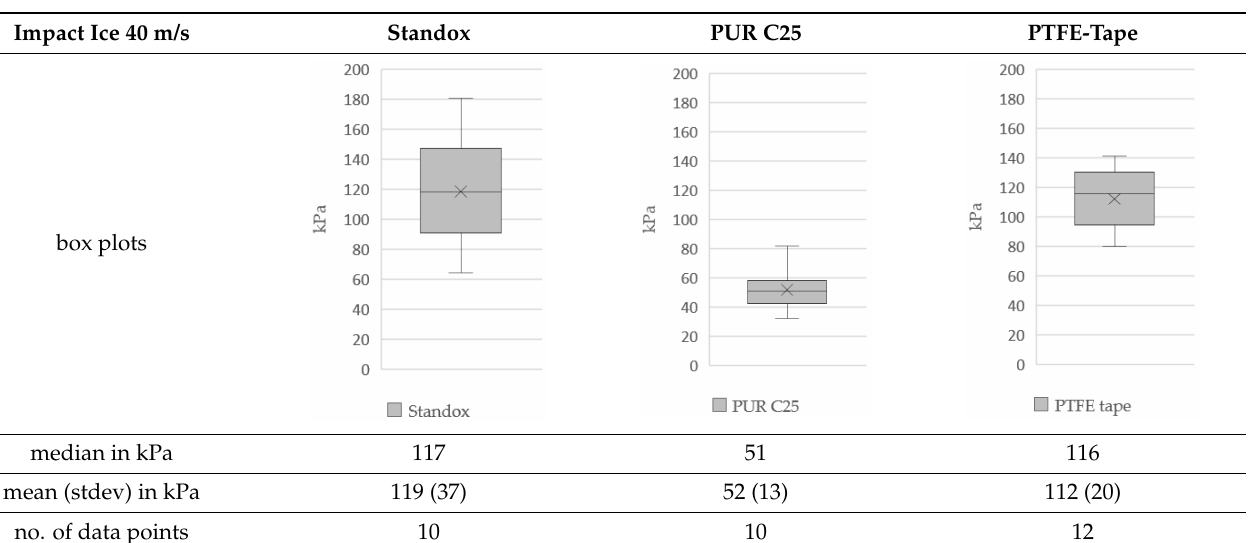
Table 7. Ice adhesion centrifuge test results for impact ice (40 m/s; acceleration speed: 200 rpm/s) with relevant statistical data for result evaluation.